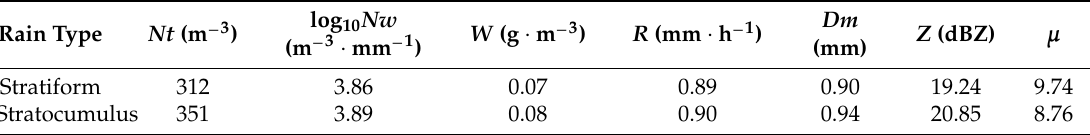
Figure 5. Raindrop size distributions (DSDs) and Gamma distribution fitting curves for stratiform and stratocumulus precipitation. Table 1. Average values of microphysical parameters for stratiform and stratocumulus